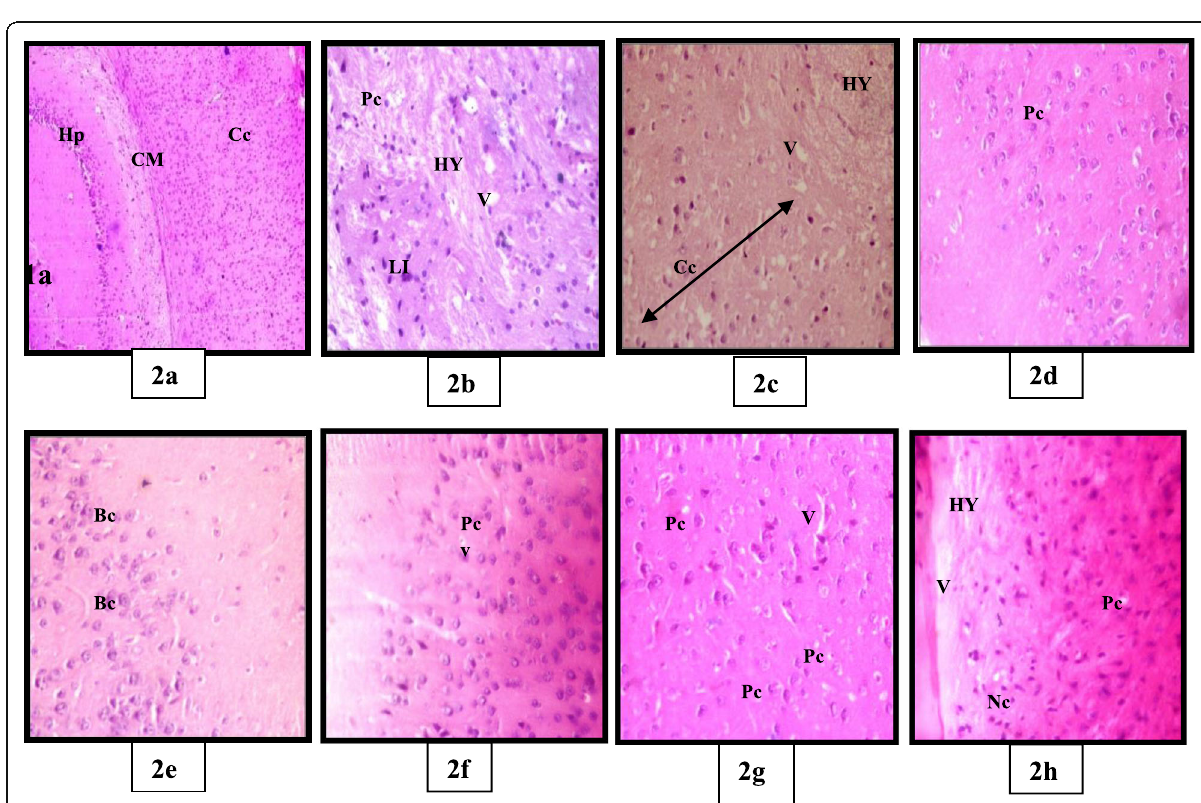
Fig. 2 Photomicrograph of cerebral cortex of mice. a Control group showing normal architecture of cells of cerebral cortex (Cc) with medulla (CM). × 200. b Cd group showing hyperemia (HY) in the cortex with vacuolation (V), lymphocytic infiltration (LI), and with the appearance of pyknotic cells (Pc). Protective Groups c Cd + GE group showed improvement in the nerve cells in many areas with little vacuolation (V) in the tissue. d Cd + TE-treated group, the cortex appeared to be normal with all the different types of cells having a compact nucleus in the neurophil. e Cd + GE + TE group showing normal cortex structure with pyramidal cells but some binucleated cells were also seen. Therapeutic Groups f Cd + GE-treated group, the pyramidal and granule cells were slightly affected with a dark-stained nucleus but mild shrinkage in the cells with a pericellular halo was visible. g Cd + TE group showed almost normal with pyramidal cells, granular cells, and neuroglial cells in the neurophil of the cortex with less pyknotic cells (Pc) and vacuolation (V). h Cd + GE + TE group, the cortex showed many normal cells with slight hyperemia of blood capillary and necrotic cells (Nc). Shrinkage was also seen in the cells with pericellular halos. × 400, H & E